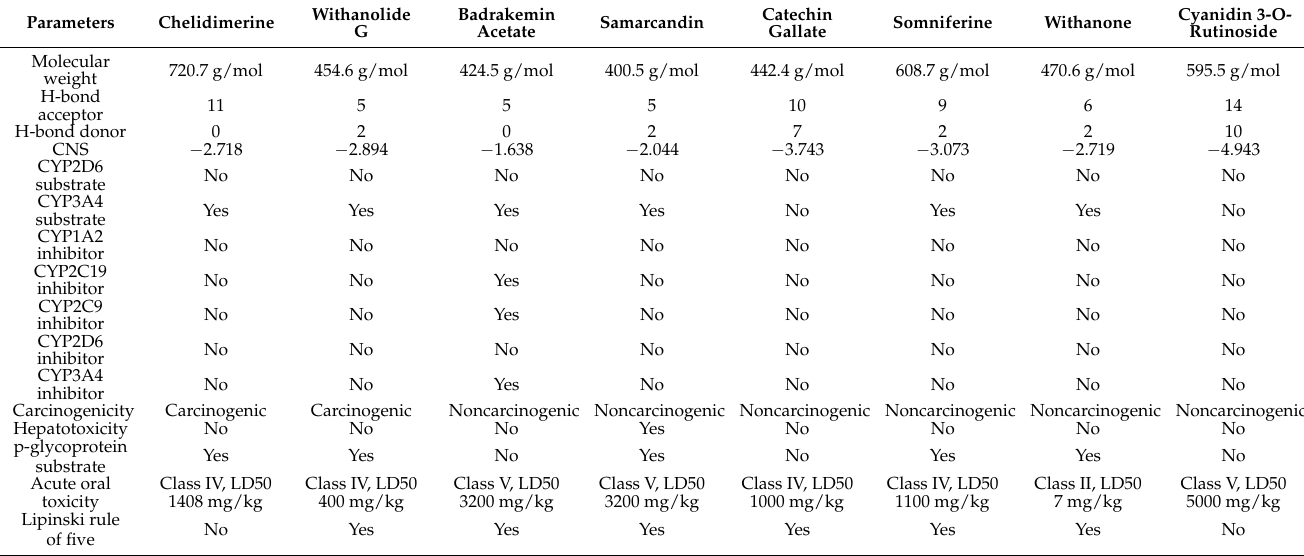
Table 4. Pharmacological properties of the top potential candidates derived from swissADME, ProTox-II, and pkCSM. Parameters Chelidimerine Withanolide G Badrakemin Acetate Molecular weight